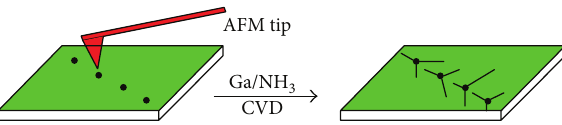
Figure 1: Schematic of the DPN process for the patterning of catalysts and growth of GaN nanowires. Reprinted with permission from [7]. Copyright 2004 American Chemical